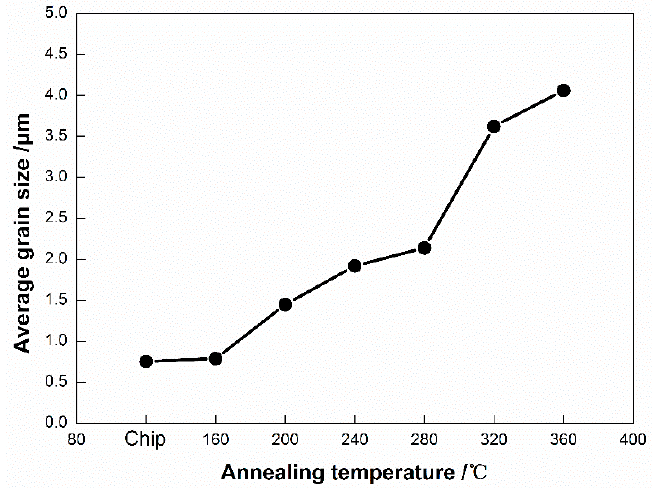
Figure 5. Grain size evolution at different annealing temperatures.